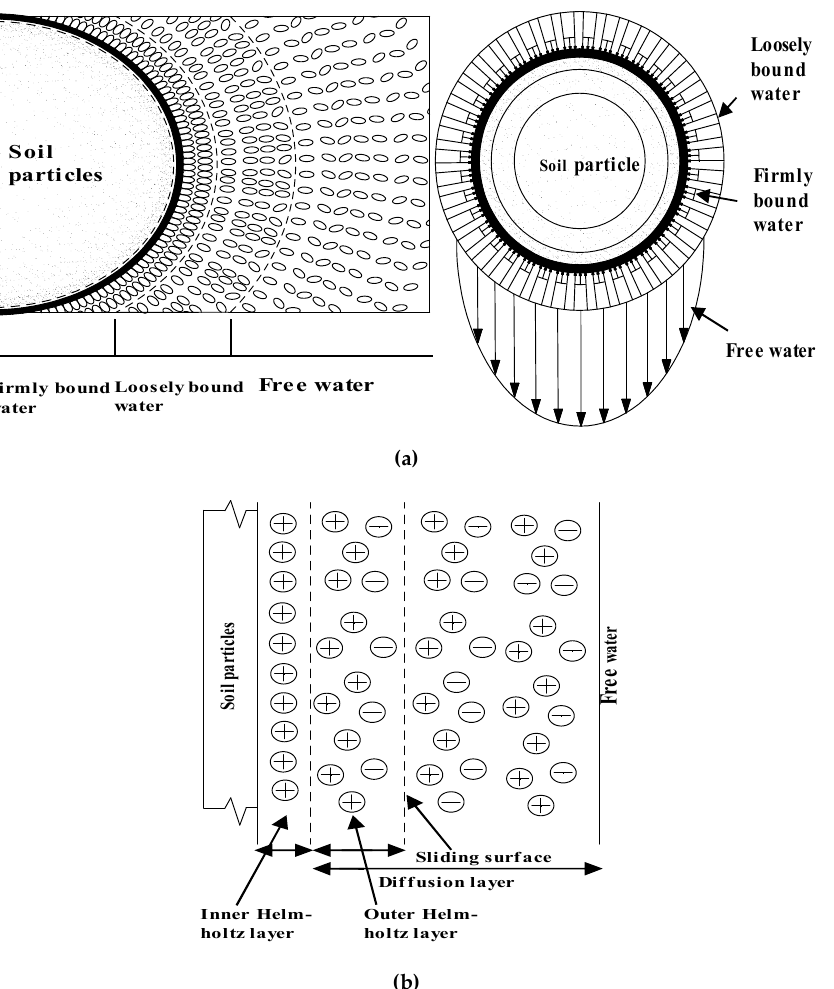
Figure 8. Distribution of water molecules between soil particles; ( a ) soil particles and intergranular water; ( b ) schematic diagram of electrical double layer on the surface of soil particles.